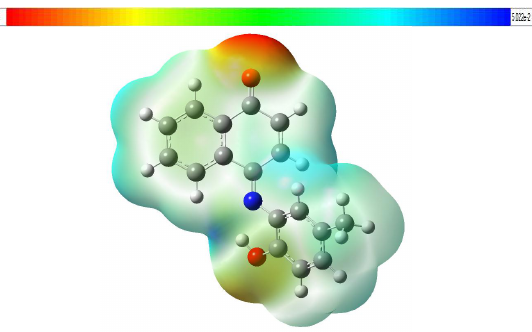
Figure 8: Molecular electrostatic potential (MEP) of PINQ molecule in which electron-rich and poor regions are shown by red and blue colors, respectively.